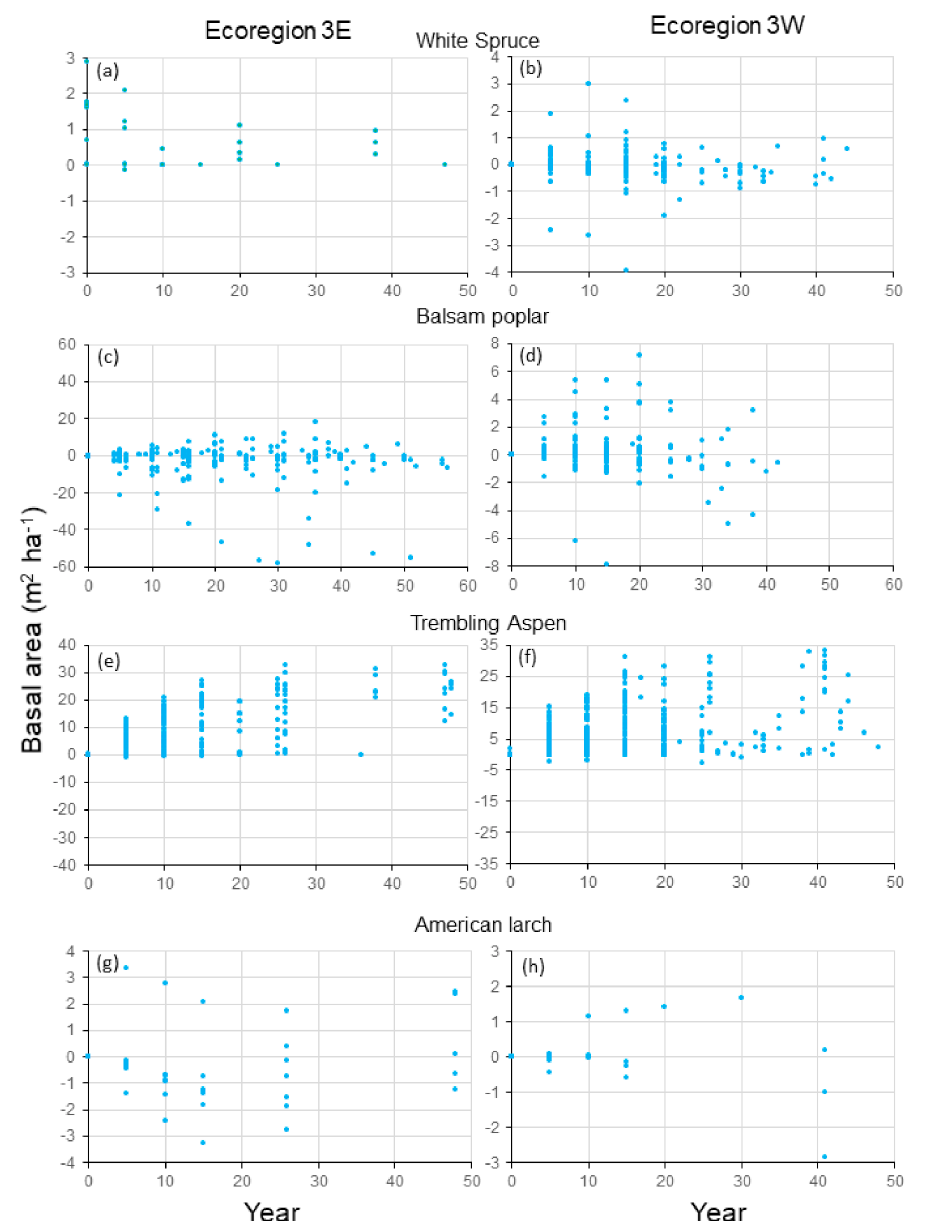
Figure 5. Graphs of differences between observed and predicted basal areas for white spruce ( a , b ), balsam poplar ( c , d ), trembling aspen ( e , f ) and American larch ( g , h ) over years in ecoregions 3E and 3W of the boreal forest region of northern Ontario,